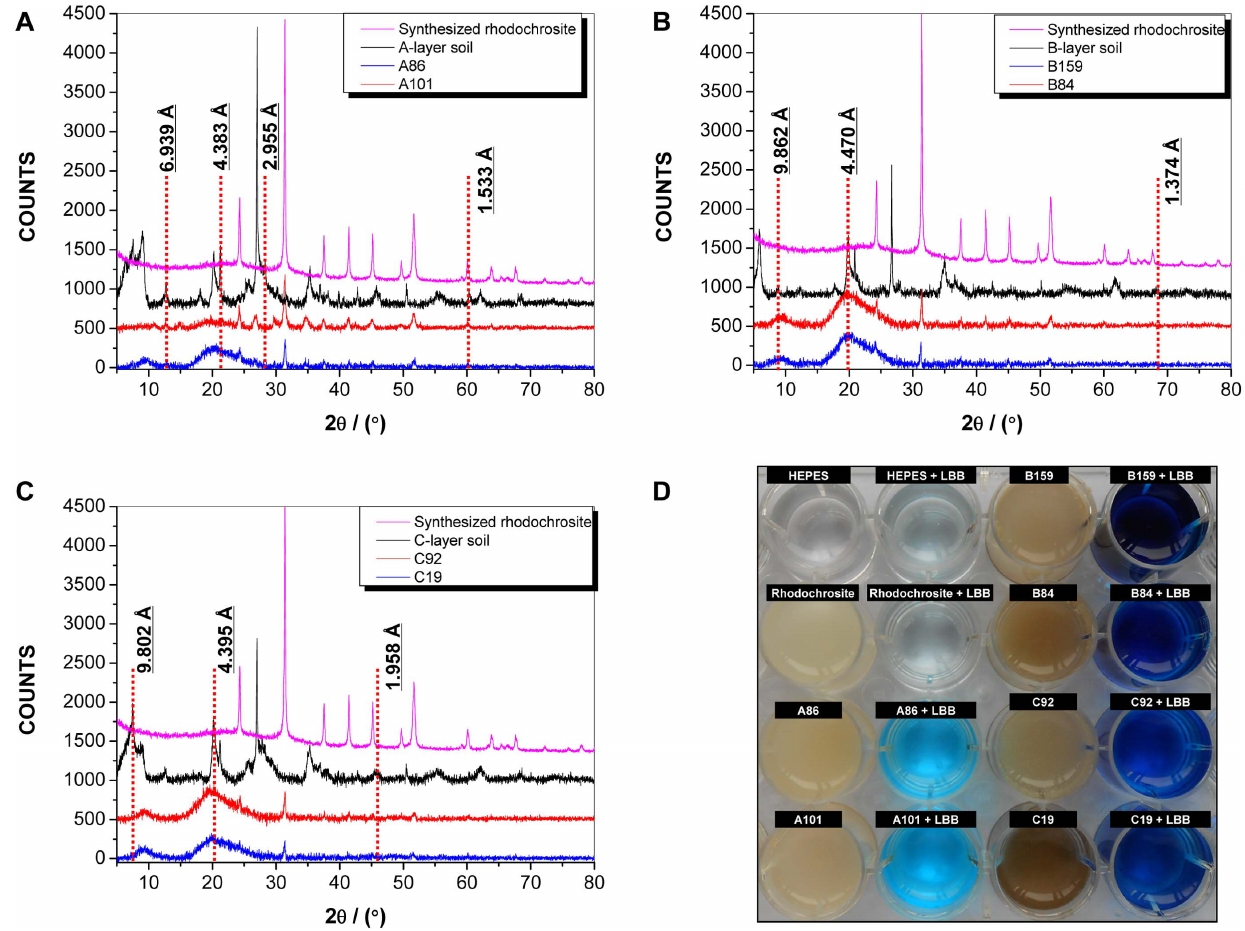
Figure 5. XRD patterns (A, B, and C) and LBB tests (D) of Mn oxides from different depths of soils and Mn oxides from different Mn(II)-oxidizing bacteria. The experiments were performed using dried powdered Mn oxide samples. In A, B, and C, the red dashed lines indicate the overlapping peaks; In C, a HEPES buffer and a synthesized rhodochrosite sample were used as the negative controls.